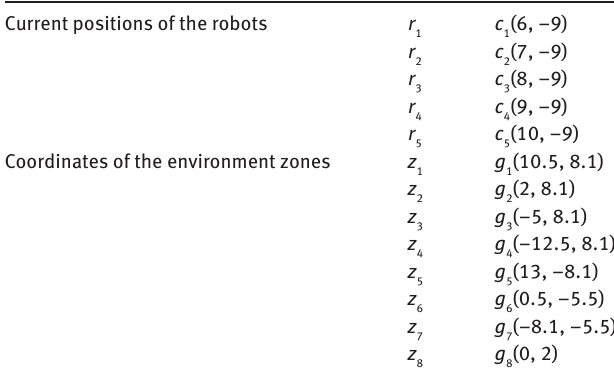
Table 2: Parameters of the Considered Validation